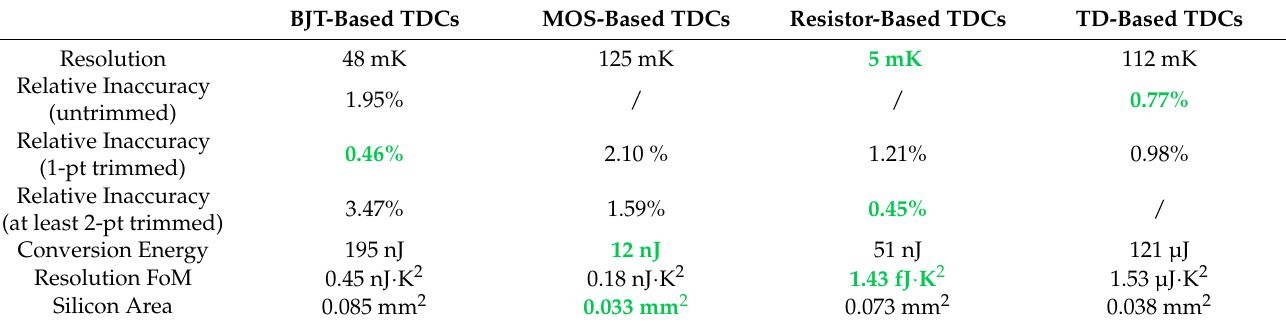
Table 4. Performance recap of the different TDC sensing types.